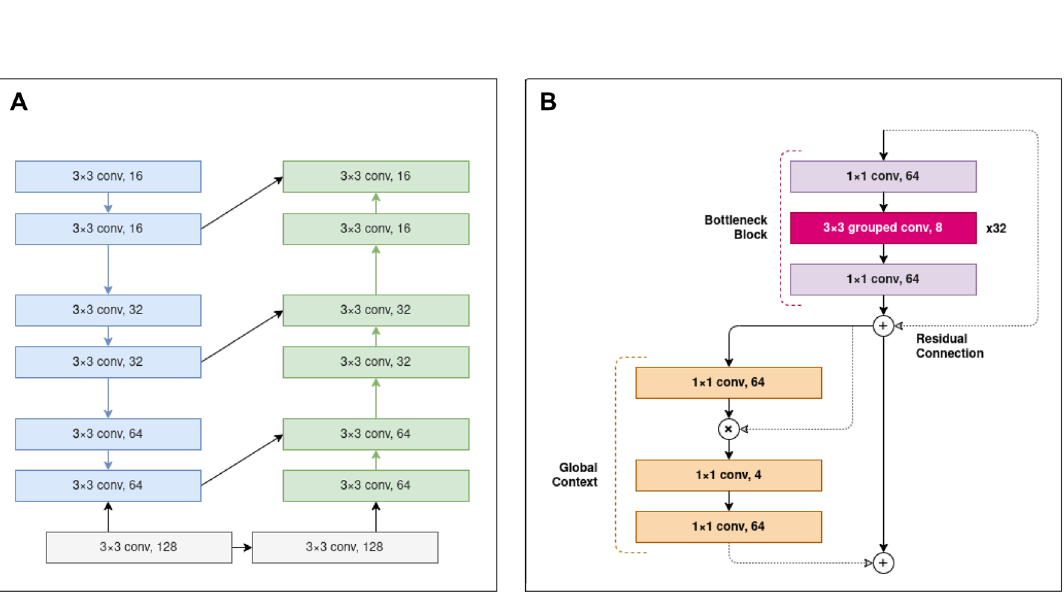
Figure 7. Details of the convolutional backbones of the proposed PreSANet model. ( A ) Preprocessor sub- module consisting of a downsampling and upsampling branch with skip connections taking a 2D image as input and returning a normalized 2D image as output. ( B ) Convolutional blocks in the feature extractor module consist of a residual bottleneck unit with depthwise-separable group convolutions followed by a global context unit. Every bottleneck unit outputs four times as many channels as it takes at its input, using 32 grouped convolutions with a 3 × 3 kernel. Downsampling is performed in the middle layer of the bottleneck block using a stride of 2. Residual skip connections sum the input of the bottleneck block into its output. Self-attention is modelled with a context-modelling layer using an element-wise product. The residual addition of an attention map to the output of each block allows the model to process global context and attend salient parts of the image. Figure created with